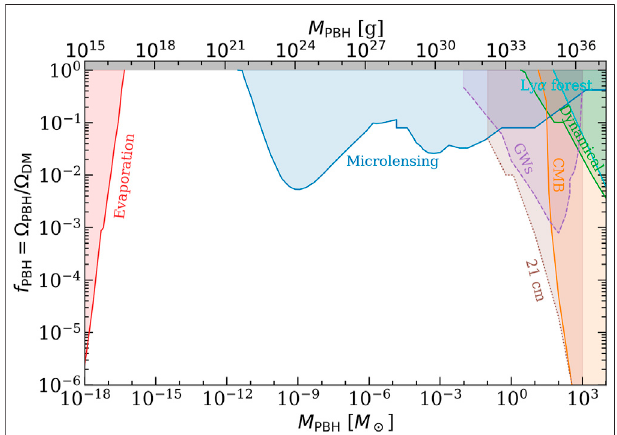
FIGURE2| Compilation ofconstraints onthePBHfraction (withrespect to DM) as a function of the PBH mass, assuming a monochromatic mass function. The different probes considered are: impact of PBH evaporation (red) ontheextragalactic c -raybackground (Carr et al.,2010)and on the CMB spectrum (Clark et al., 2017); non-observation of microlensing events (blue) from the MACHO (Alcock et al., 2001), EROS (Tisserand et al., 2007), Kepler (Griest et al., 2014), Icarus (Oguri et al., 2018), OGLE (Niikura et al., 2019b) and Subaru-HSC (Croon et al., 2020) collaborations; PBH accretion signatures on the CMB (orange), assuming spherical accretion ofPBHs within halos(Serpicoetal.,2020);dynamicalconstraints,suchasdisruptionofstellar systems by the presence of PBHs (green), on wide binaries (Monroy- Rodríguez and Allen, 2014) and on ultra-faint dwarf galaxies (Brandt, 2016); power spectrum from the Ly α forest (cyan) (Murgia et al., 2019); merger rates from gravitational waves (purple), either from individual mergers (Kavanagh et al., 2018; Abbott et al., 2019) or from searches of stochastic gravitational wave background (Chen and Huang, 2020). Gravitational waves limits are denoted bydashed lines,sincetheycouldbeinvalidated(Boehmetal.,2021). Dotted brown line corresponds to forecasts from the 21 cm power spectrum with SKA sensitivities (Mena et al., 2019) and from 21 cm forest prospects (Villanueva-Domingo and Ichiki, 2021). Figure created with the publicly available Python code PBHbounds (Kavanagh,